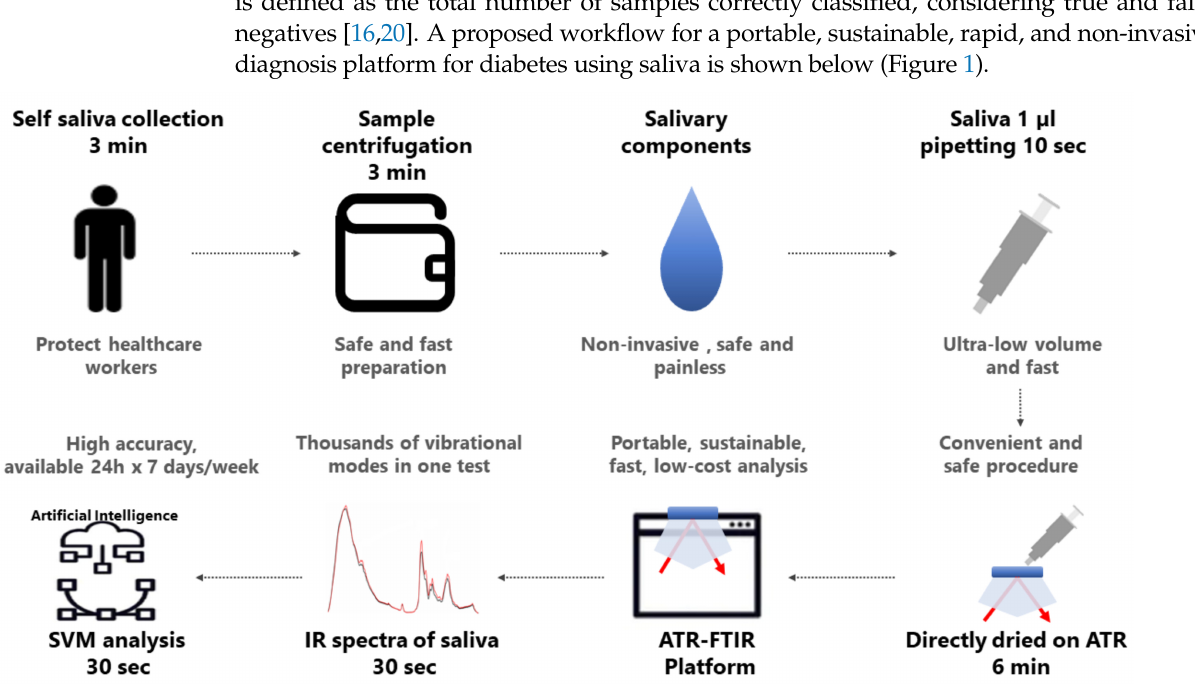
Table 1. Characterization of patients: gender, body weight, age, glycemia, and glycated hemoglobin (HbA1C).